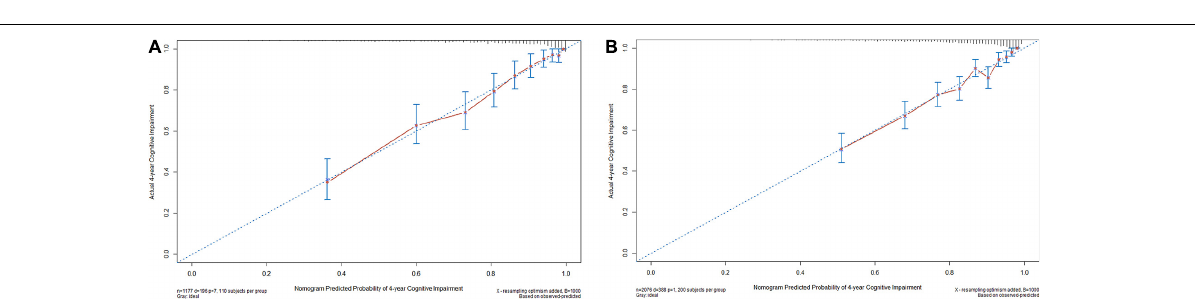
FIGURE 3 | The internal (A) and external (B) calibration curves of the nomogram. Nomogram-predicted probability and observed frequency over 4 years for cognitive impairment among participants with normal cognition at baseline were plotted in the x - and y -axis, respectively. The gray line indicates the ideal plot for the calibration curve, where the nomogram-predicted probabilities perfectly match the observed probabilities in all